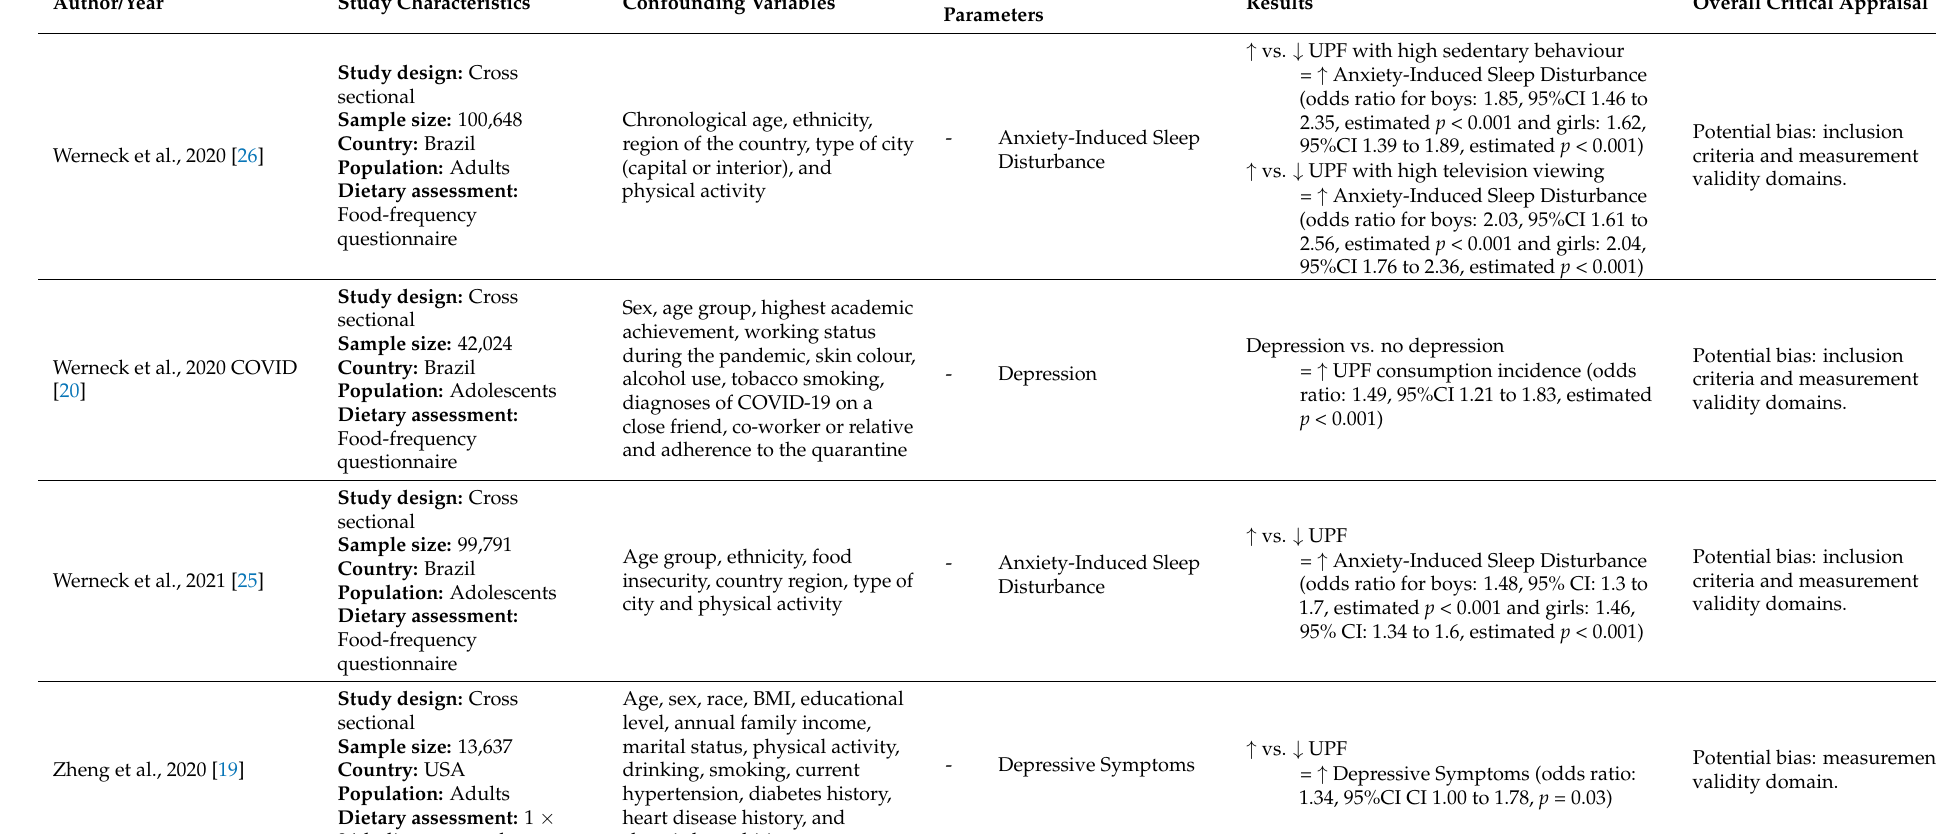
Table 1. Study characteristics and key